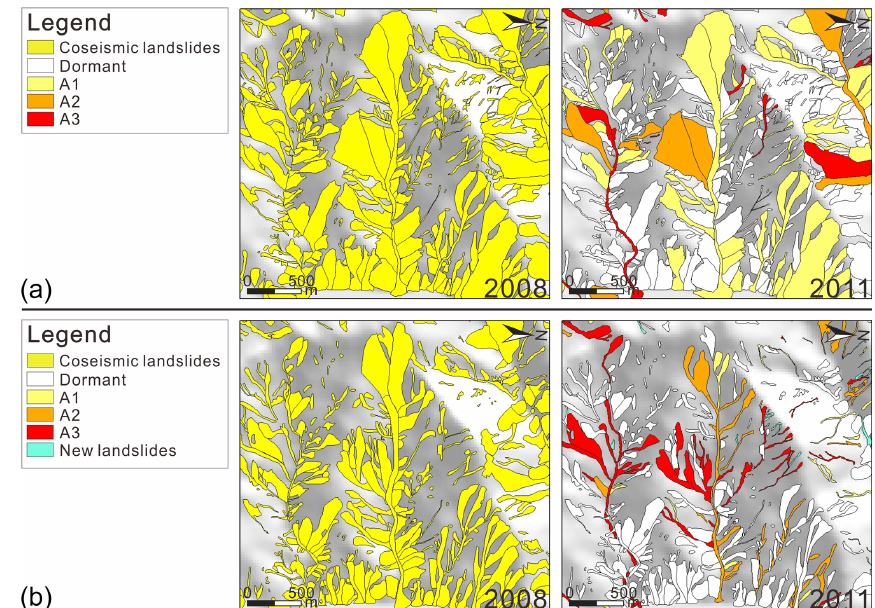
Figure 5. Comparison between the landslide mapping by Tang et al. (2016) and that of the present work in a portion of the study area, using the remote-sensing scene recorded in 2011. Note that Tang et al. (2016) use the polygons delineating the coseismic landslides (2008 scene) and estimate the proportion of landslide area remobilised as of 2011, providing this estimation in the attributes table of the map. Conversely, in this work the remobilised areas were remapped with new polygons in each post-earthquake scene. In this way, not only can the remobilised area be calculated, but the spatial characteristics of the remobilisations can also be